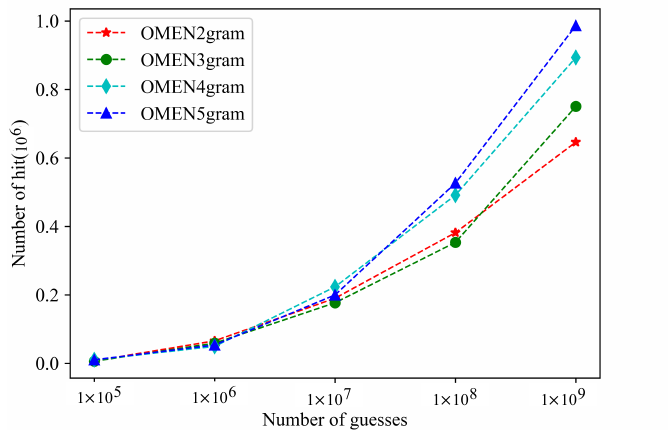
Figure 3. The hits of OMEN models.